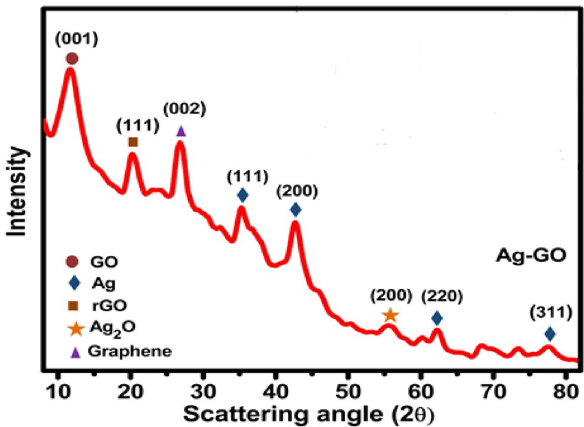
Figure 3. XRD pattern of Ag–GO sample.